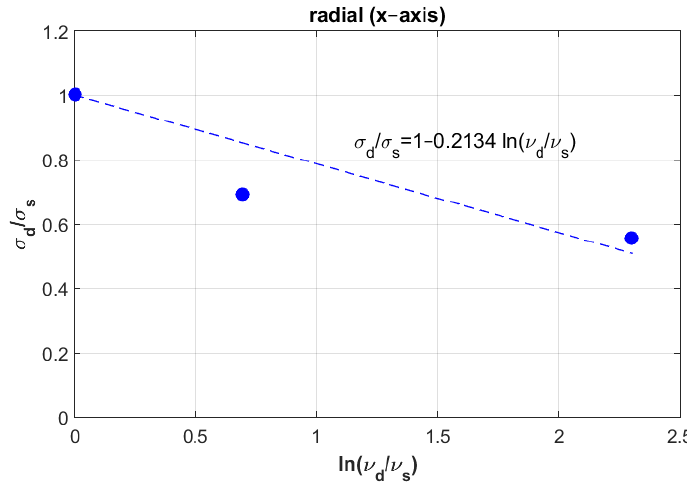
Figure 4. Determination of constant